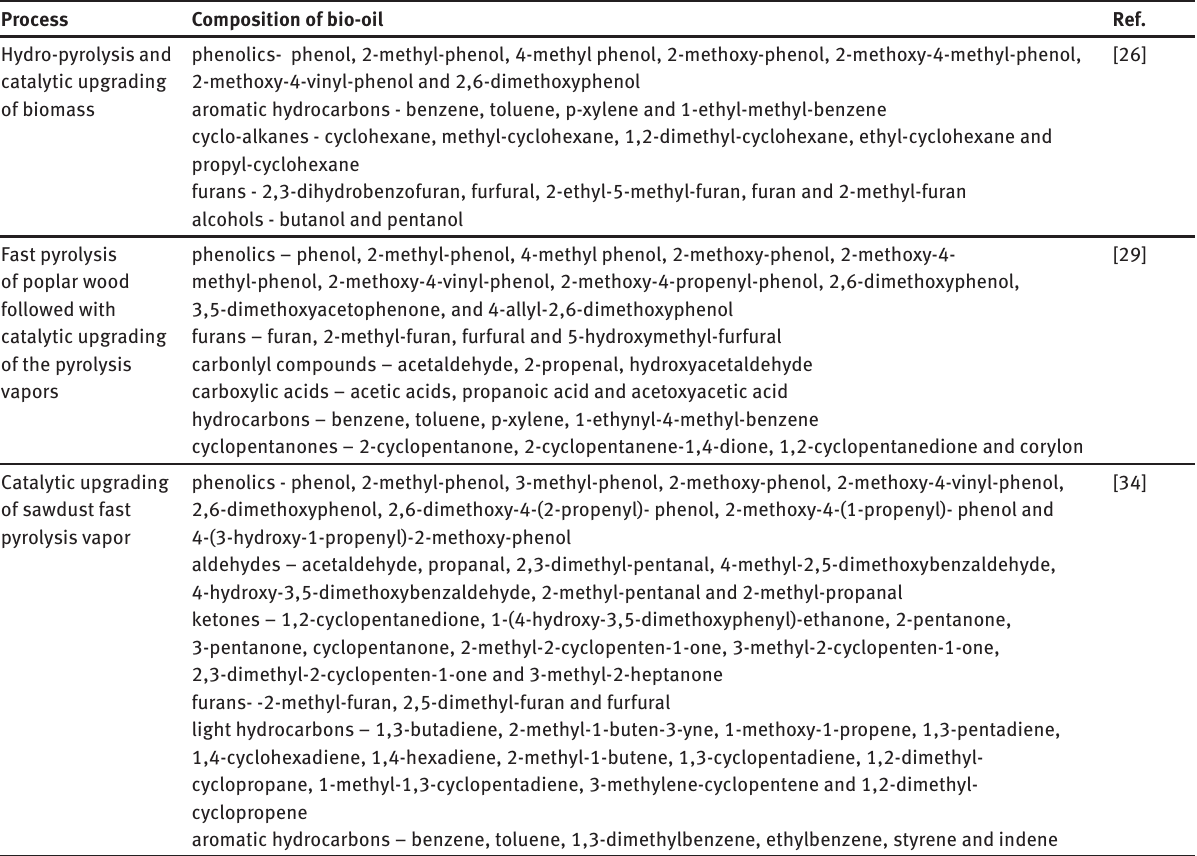
Table 3 Exemplary composition of bio-oils formed in fast prylolysis of lignocellulosic biomass Process